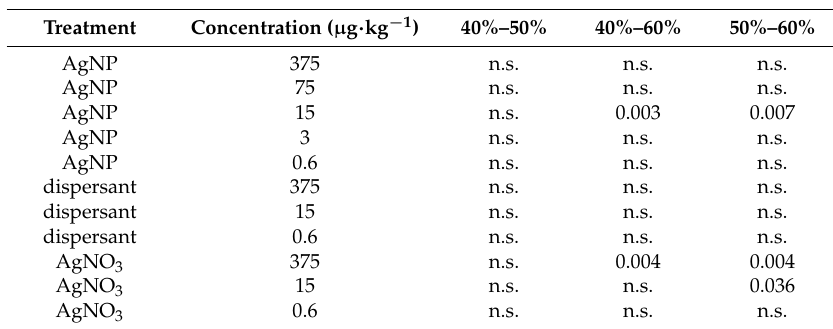
Table 1. Comparison of F. candida reproduction between treatments with different water content (percent of maximum water holding capacity). The unit is µ g Ag · kg − 1 soil and the dispersant treatments contain the same amount of dispersant as the AgNP treatment labeled with the same concentration. n.s. indicates no significant difference in the number of juveniles after the 28-day test. If there is a significant difference between the respective treatments, the p -value of the post hoc Dunnett test ( p > 0.05) is shown. n =